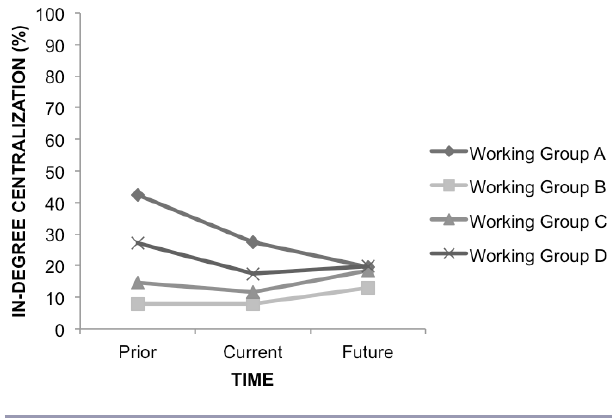
Fig. 3 . Working group centralization over time. Centralization measures reflect the overall integration of a network. Larger centralization values indicate that a single actor is more central in the network than the other actors and, thus, prominent structural positions are unequally distributed.